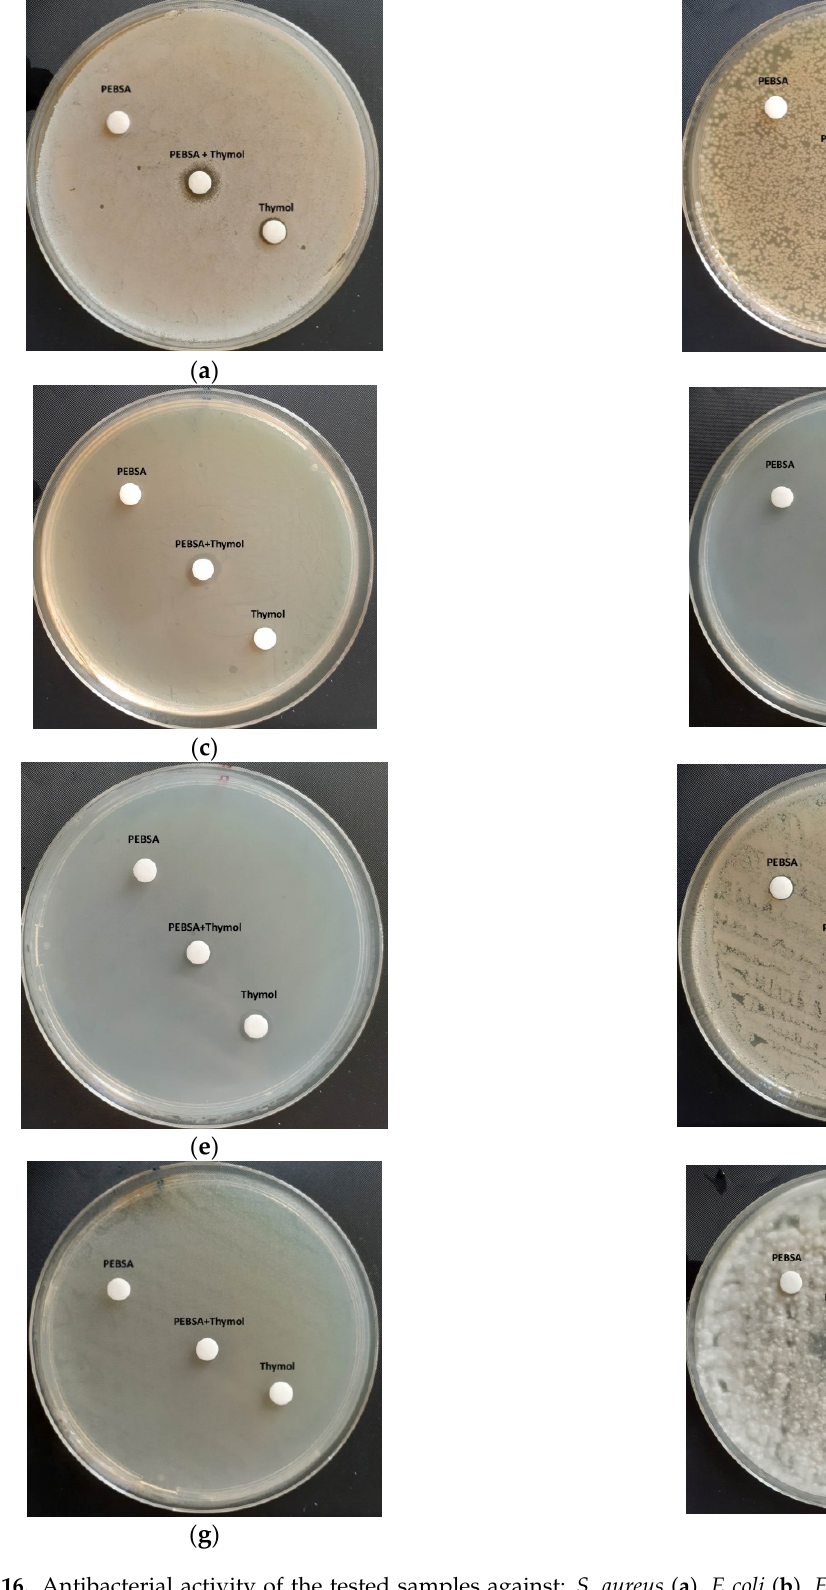
Figure 16. Antibacterial activity of the tested samples against: S. aureus ( a ), E coli ( b ), E faecalis ( c ), K. Pneumoniae ( d ), S . typhimurium ( e ), C. Albicans ( f ), C. Glabrata ( g ), and A. brasiliensis ( h ). MIC and MBC of PEBSA samples were not determined due to the fact that the compound did not present antimicrobial activity. MIC for all the other tested samples